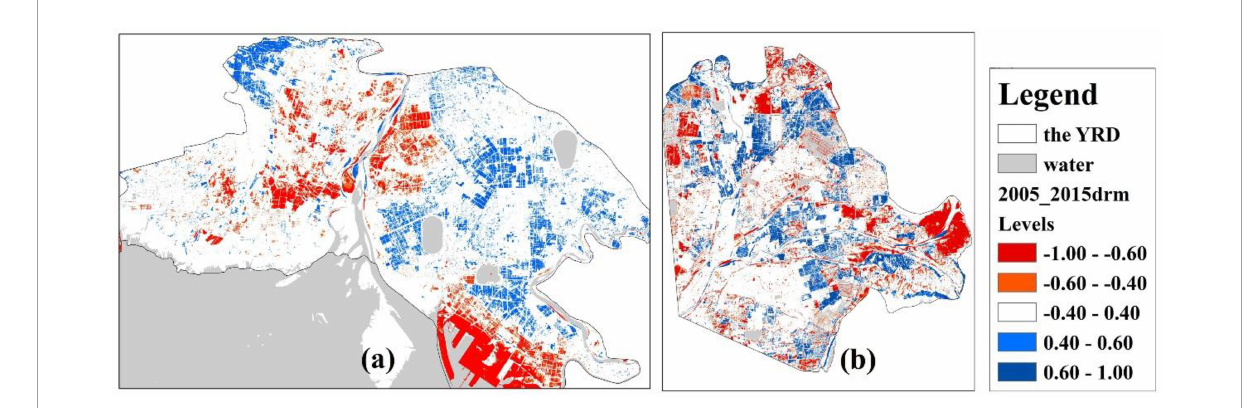
FIGURE3 The assessment of inter-annual changes to Ecological factors in (a) Shuangtai Estuary, and (b) Yellow River Delta, 2015.